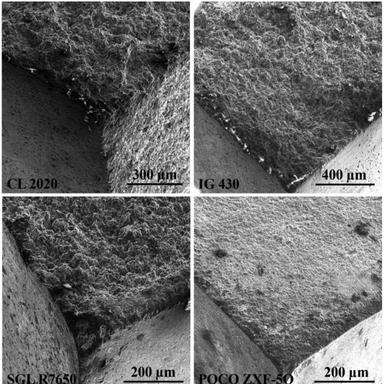
High resolution secondary electron SEM images of freshly fractured surfaces (FFS) of the four grades of graphite at low magnifications, viewed from the corner with the top surface being the FFS.